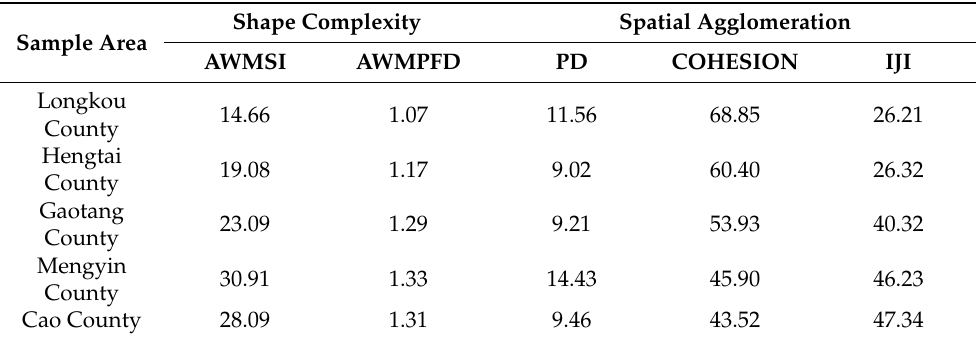
Table 8. Calculation results of the landscape metrics of rural residential land in a typical area. Sample